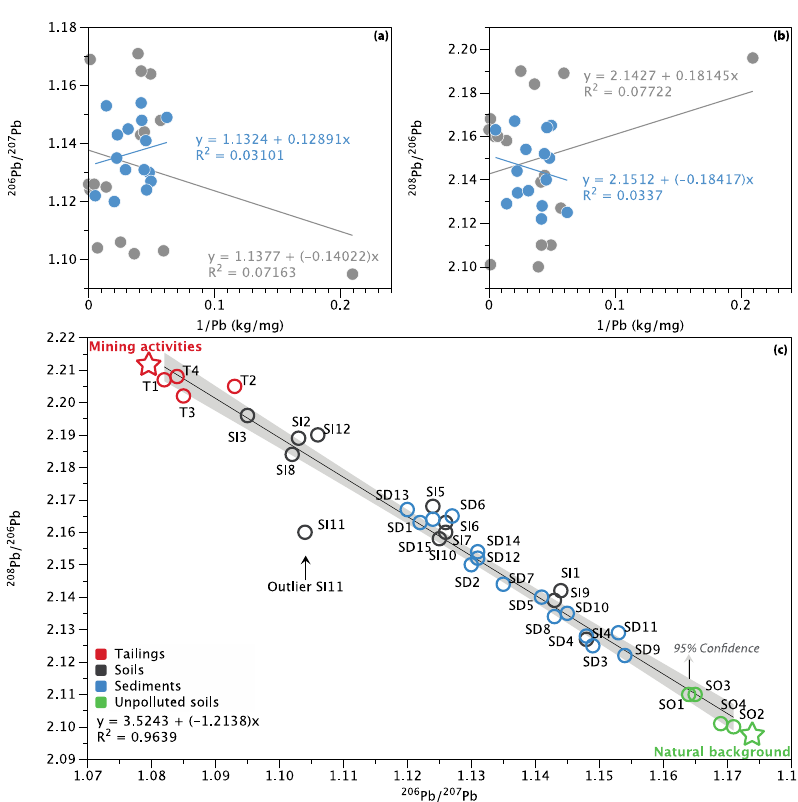
Figure 6. The plot of 206 Pb/ 207 Pb ( a ) and 208 Pb/ 206 Pb ( b ) versus the inverse of Pb concentration of the soils and sediments, as well as the plot of 206 Pb/ 207 Pb versus 208 Pb/ 206 Pb ratios of the sediments, soils, and tailings in this study ( c ).